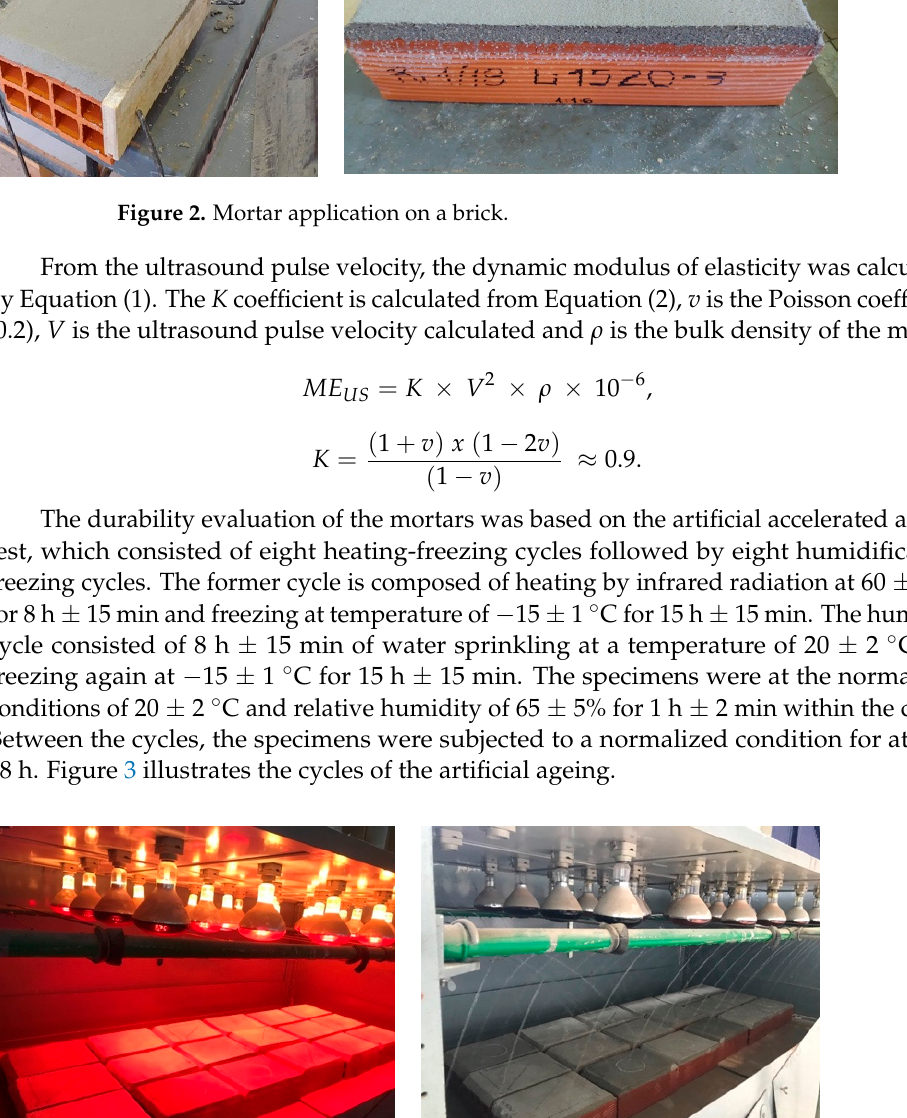
Figure 2. Mortar application on a brick.